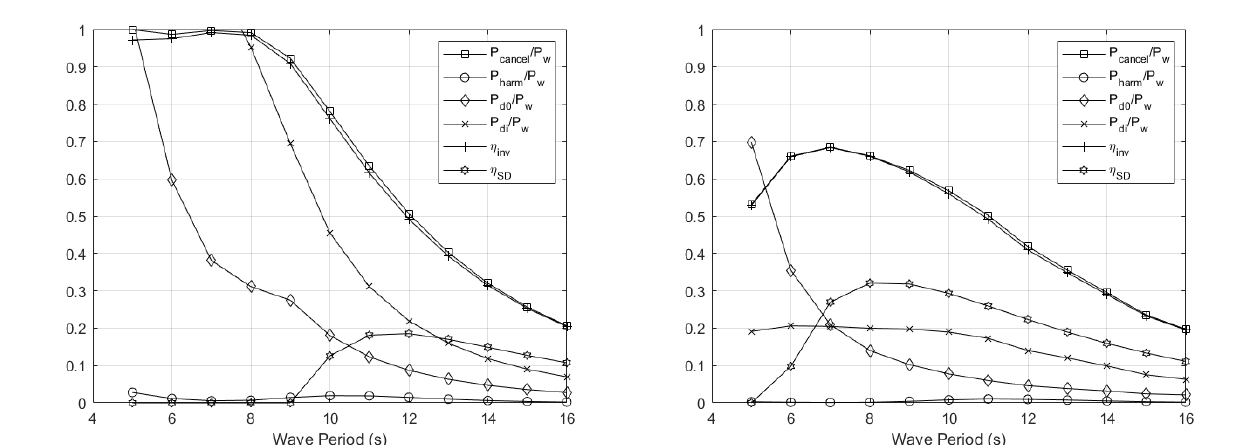
Fig. 8: Cancelled wave power, harmonic and drag power losses normalized with incoming wave power and inviscid and total efficiency of power conversion for the CycWEC at a wave height of 2.25m. Left, controller 1. Right, controller